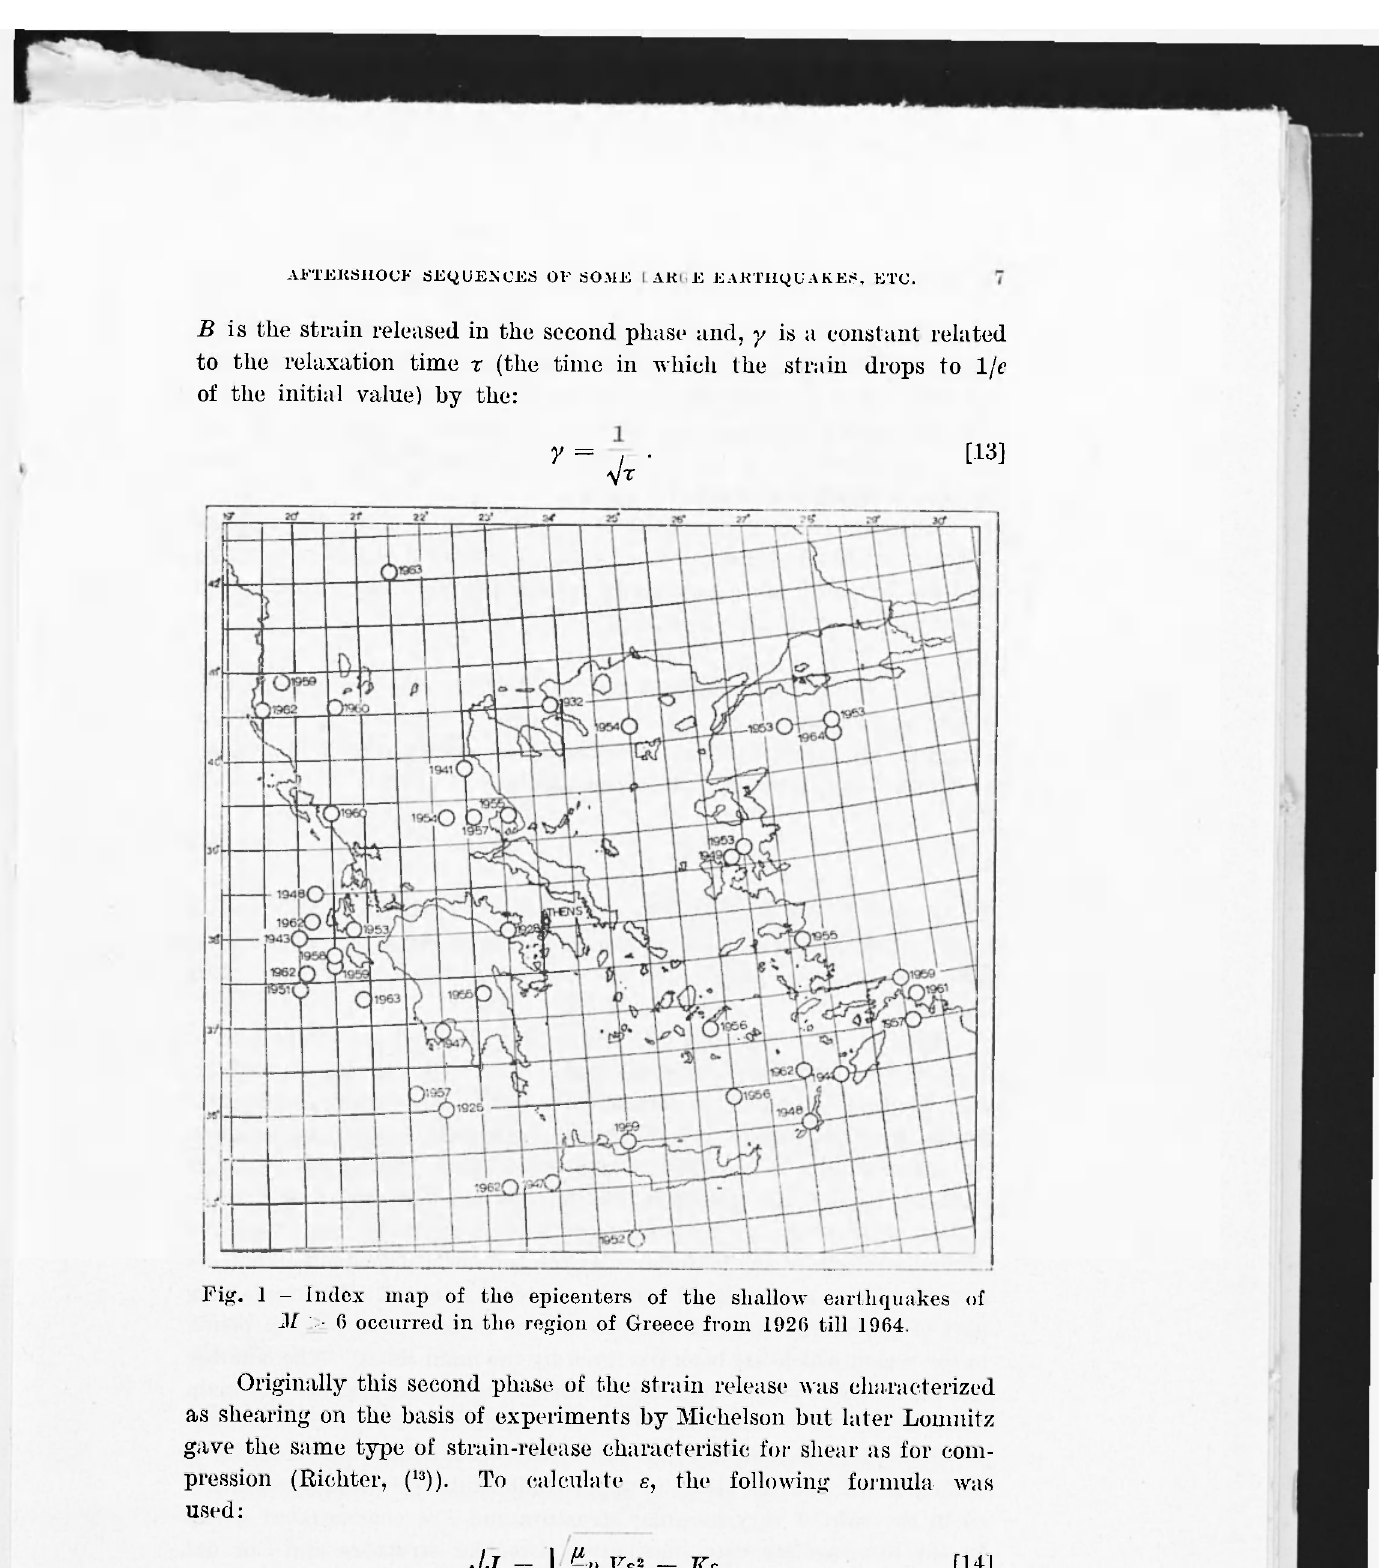
Fig. 1 - Index map of tlie epicenters of tlie shallow earthquakes of M > 6 occurred in the region of Greece from 1926 till